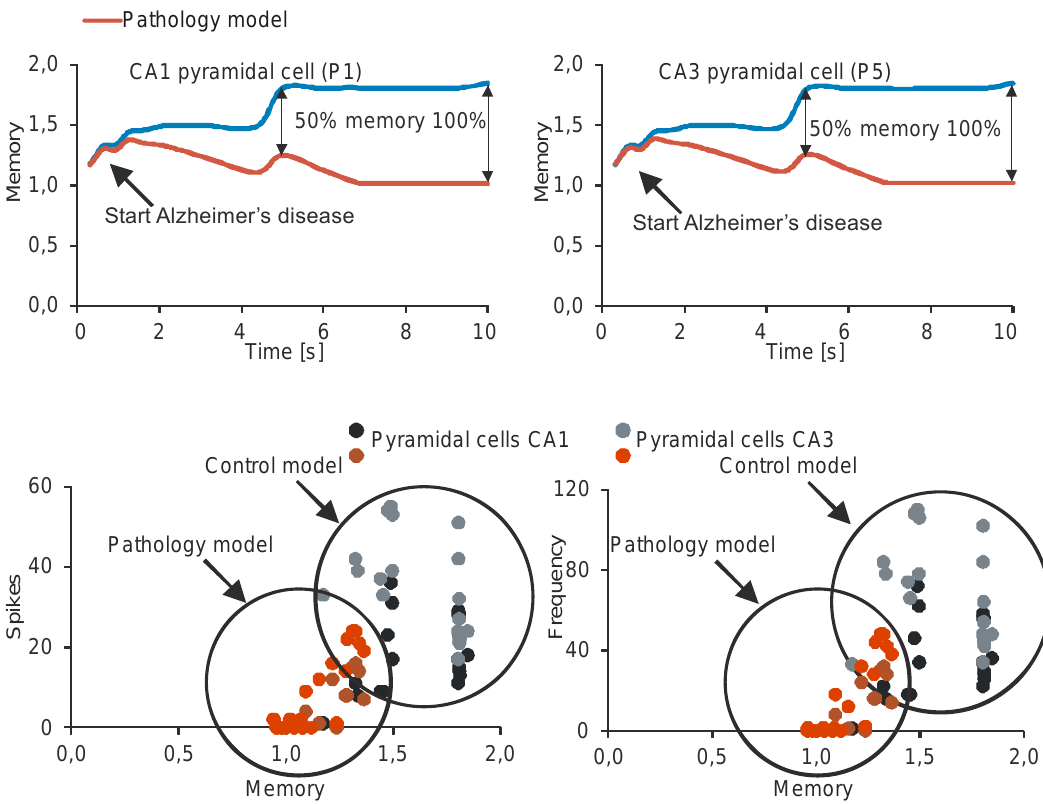
Figure 6. On the top: relationship between memory (pyramidal cells (P1 and P5)) and synaptic deletion in control and pathology models CA3 and CA1 formations. On the bottom: relationship between number of spikes and memory for control and pathology models. Filled circles for control and pathology models group output simulation train.